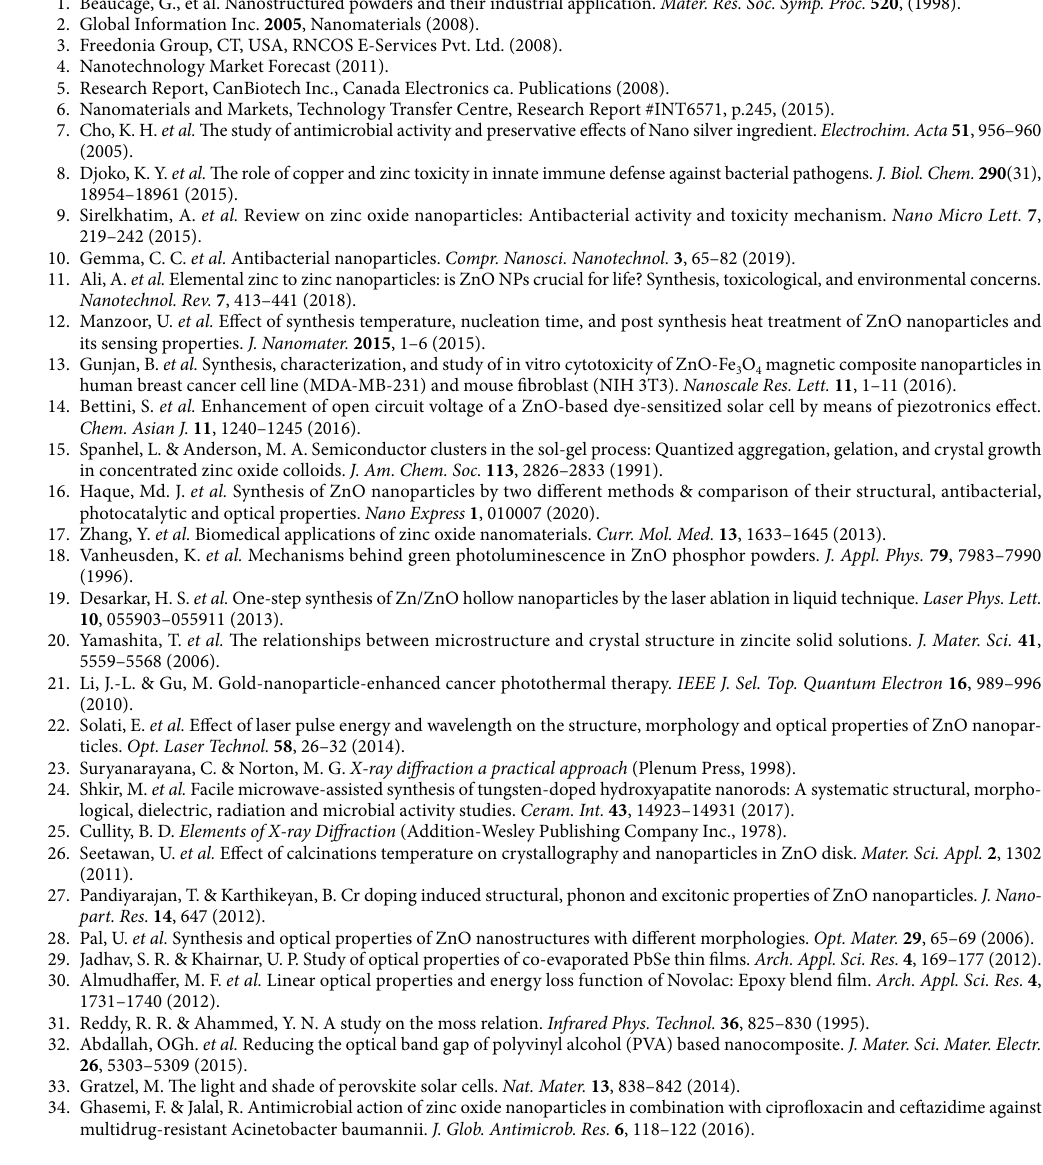
Table 6. Mean inhibition Zones of the synthesized ZnO NPs before and after irradiation by laser beam (532 nm and 1064 nm).